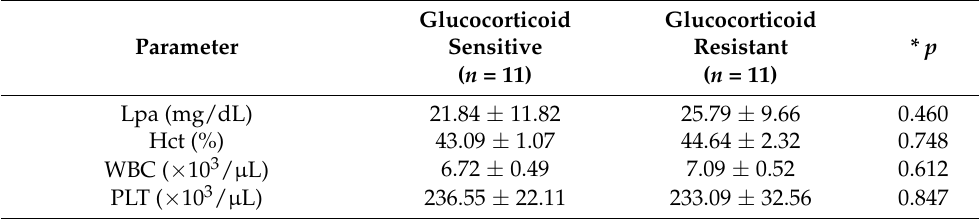
Table 2. Hematological, biochemical, and endocrinological parameters of the S and R healthy subjects determined one month after the very-low dexamethasone suppression